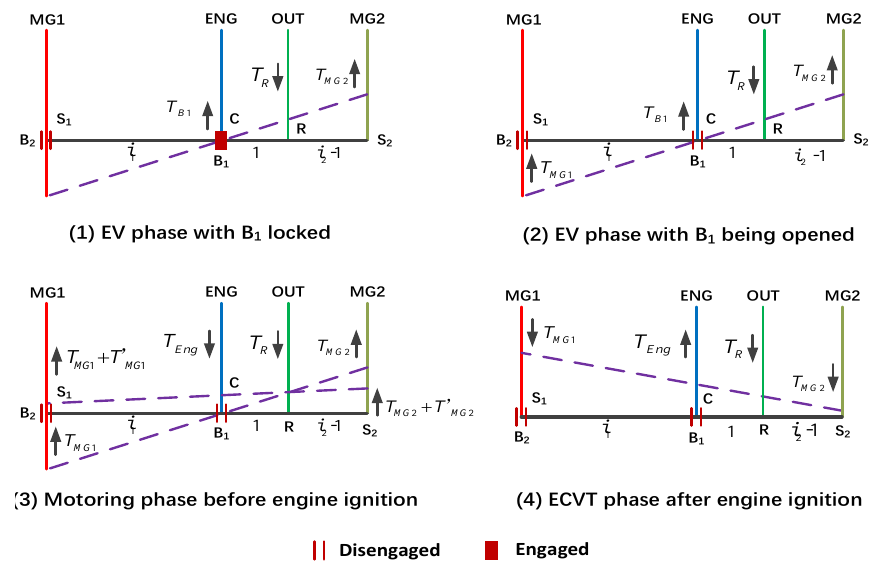
Figure 2. Lever chart during start-up process. In Figure 2, the solid black line is the lever balance line, where the speed on the balance line is zero, the speed below the balance line is negative, and the speed above the balance line is positive. The torque arrow facing upward is positive, and the torque arrow facing downward is negative.